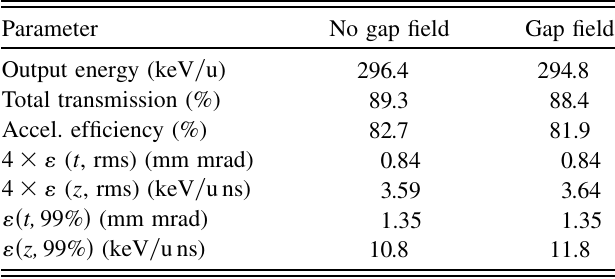
TABLE VI. Effect of the nonzero longitudinal field in the gaps between the flanges and the vanes. Comparison of the RFQ output beam parameters before and after including this effect.